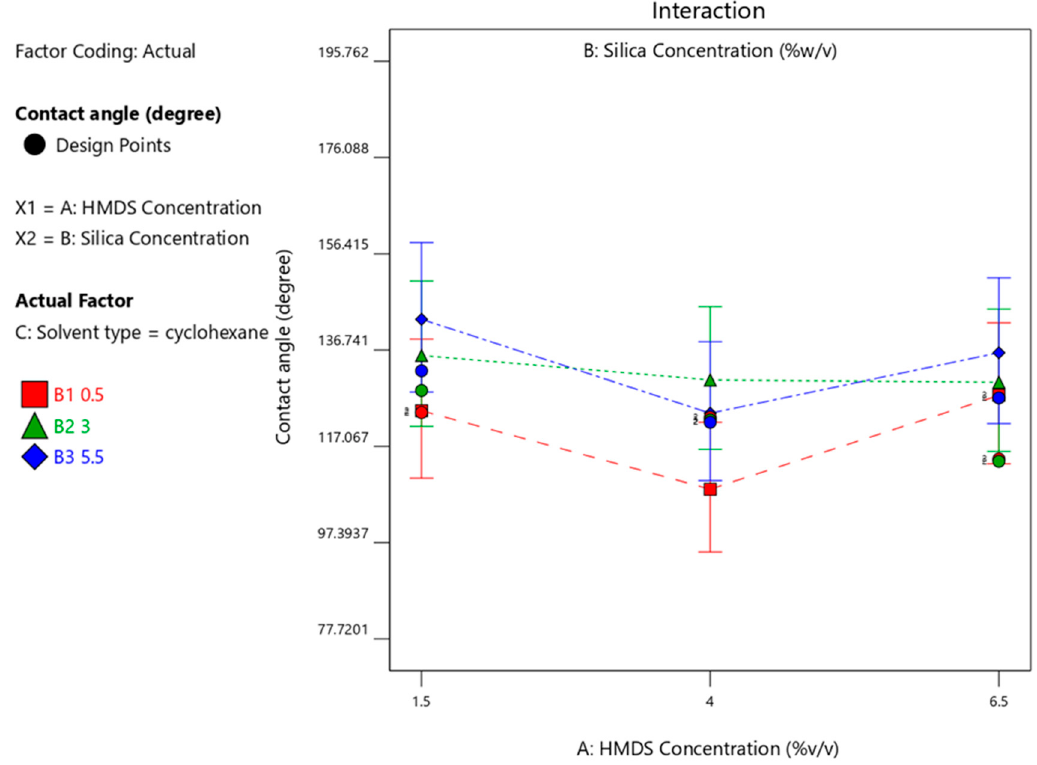
Figure 6. Contact angle response interaction between HMDS and silica concentration with cyclohexane solvent.